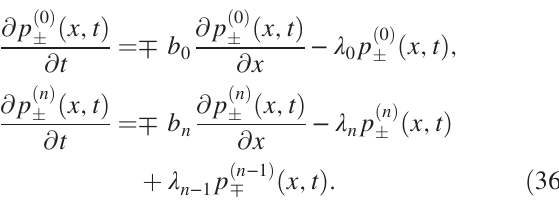
FIG. 2. Superdiffusion for the model of a transitionally senescent LW; see Eq. (38) and further specifications in the text. Here, τ 0 defines the senescence time. The special case τ 0 ¼ 0 corresponds to the conventional LW model without senescence. ξ is the exponent of the power-law distributed transition times; see Eqs. (5) and (7), respectively. For the speed of the walker, we choose b ¼ 1 . (a) Temporal evolution of the mean square displacement σ 2 x ð t Þ for ξ ¼ 1 . 5 . We see that senescence enhances superdiffusion beyond the conventional as a function of ξ increases by increasing the senescence time τ 0 ¼ 0 LW solution. (b) The scaling exponent γ eff